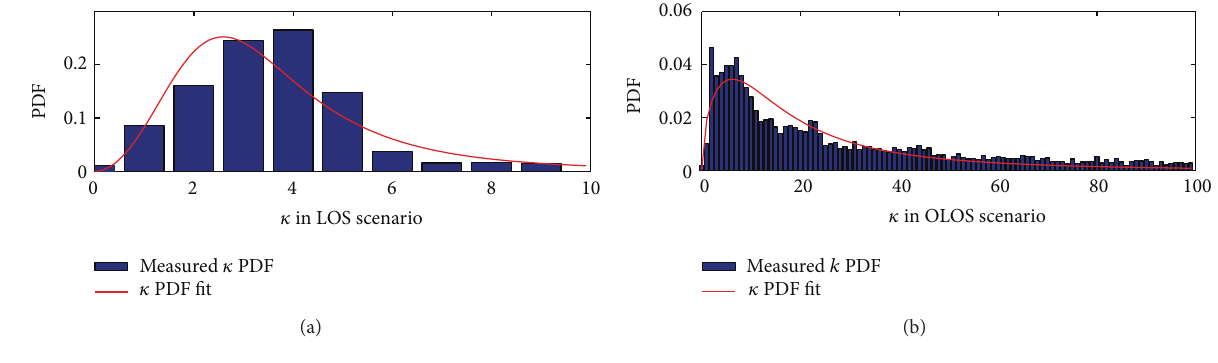
Figure 9: Statistical characteristic of ̂𝜅